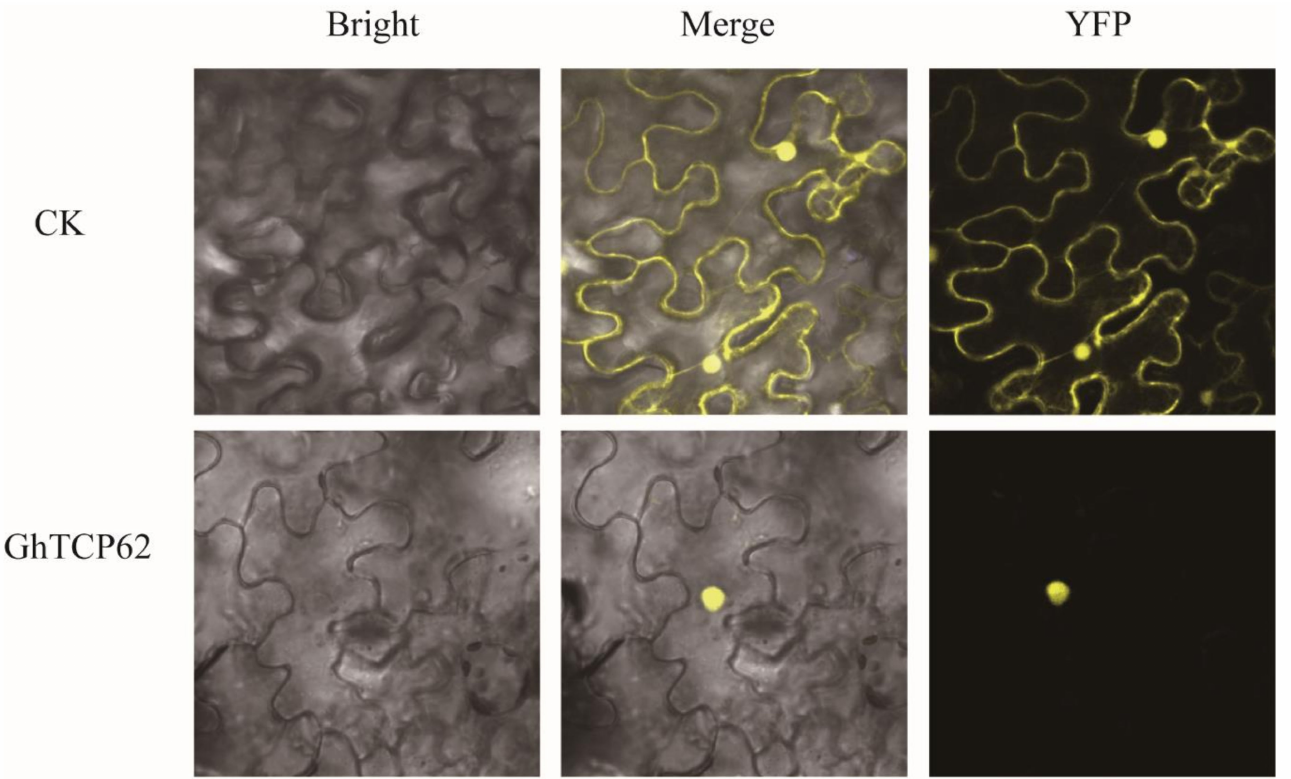
Figure 7. Subcellular localization of GhTCP62